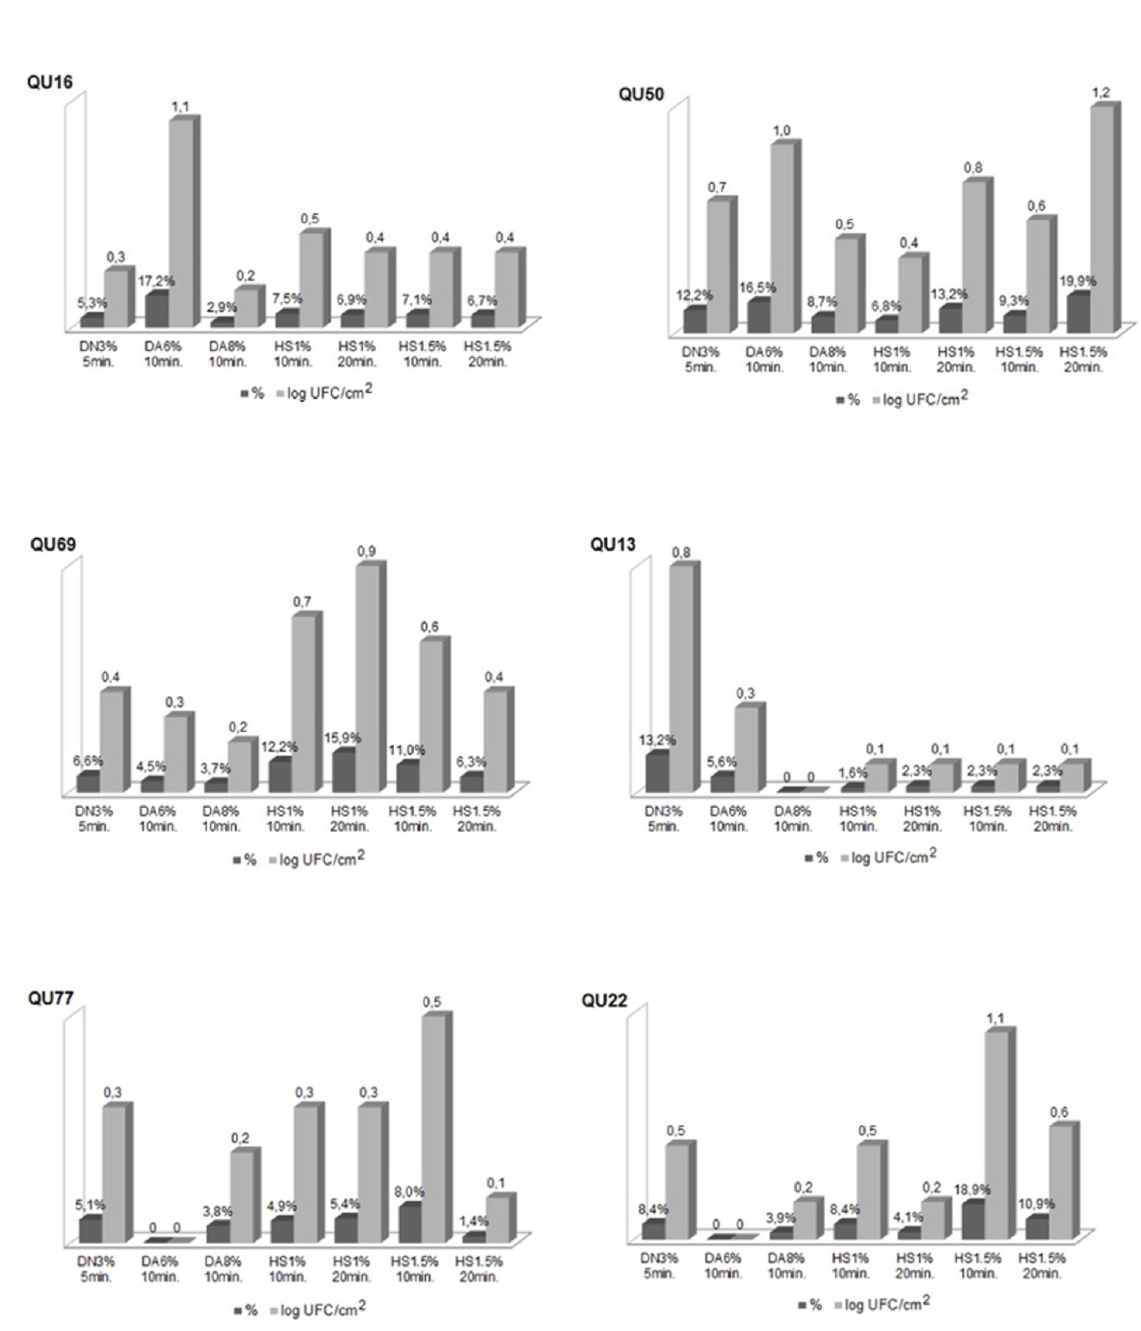
Figure 2. Survival of (a) QU16, (b) QU50, (c) QU69, (d) QU13, (e) QU77, (f) QU22 Yarrowia lipolytica isolates (log CFU/ cm2 ) on the mold coupon before and after application of sanitation product (DN 3 %) mild detergent 03 - 05 min, (DA6 %) and (DA8 %) alkaline detergent and 8 % - 6% - 10 min (HS 1 %) sodium hypochlorite 1 % - 10 to 20 min. and (HS1,5 %) sodium hypochlorite 1.5% - and 10-20